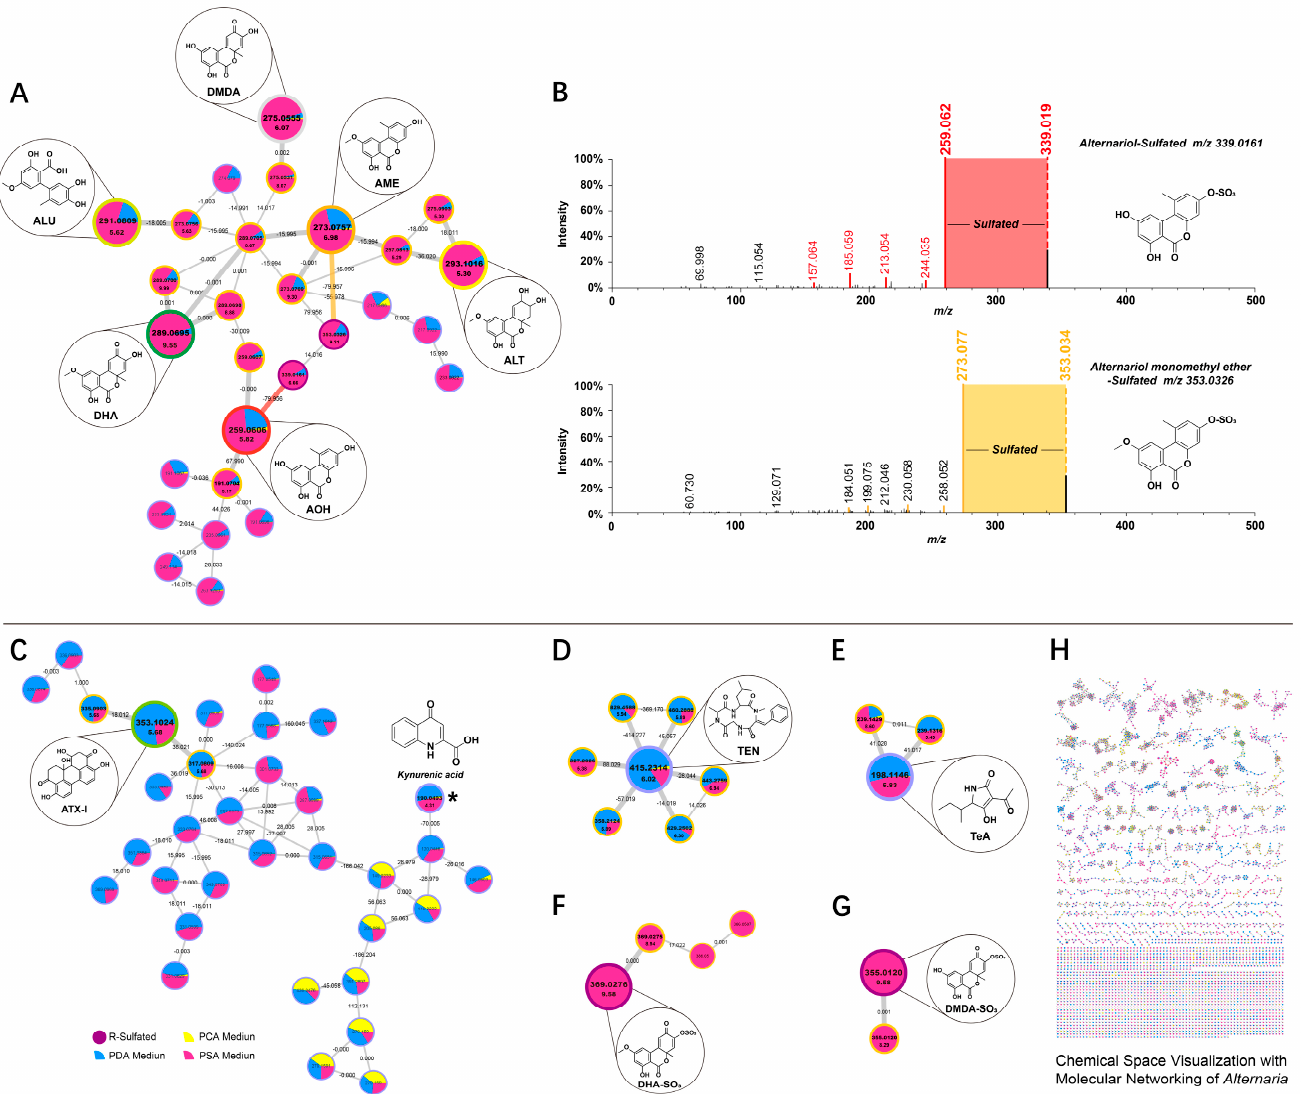
Figure 5. Visualization with Molecular Networking of the Alternaria natural product molecular family detected in PCA (yellow nodes), PDA (blue nodes) and PSA (pink nodes). ( A , C – G ) The molecular family of Alternaria metabolites. ( B ) Comparison of MS/MS spectra for AOH- and AME- sulfate conjugated. ( H ) Chemical space visualization with molecular networking of the Alternaria. ( Supplementary Materials Figure S3).